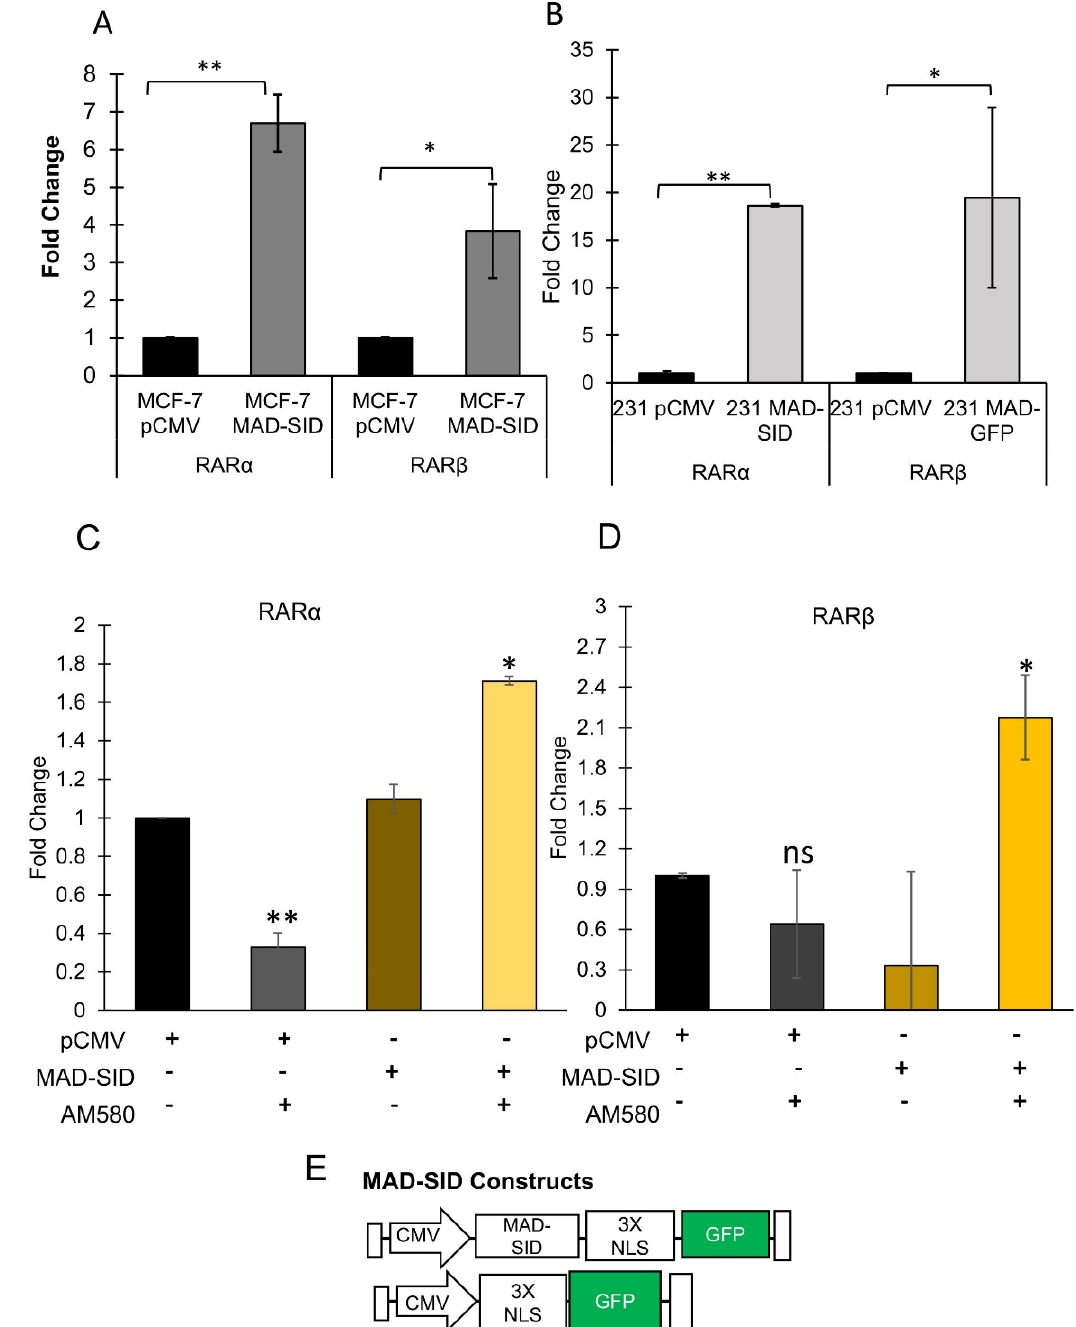
Figure 1. Expression of MAD-SID in MDA-MB 231 and MCF-7 cells increases RAR α and RAR β Expression: ( A , B ) MDA-MB 231 and MCF-7 cells were transfected with CMV-driven plasmids carrying a nuclear localization signal, GFP tag and MAD-SID sequence. The transfected cells were examined for the expression of RAR α and RAR β through RT-PCR. The expression of RAR α and RAR β increased in both the cell lines. The data presented are the mean fold change obtained from four independent experiments ( C , D ). The expression of RAR α and RAR β , respectively, was evaluated in the control (pCMV) and the MAD-SID-overexpressing MDA-MB-231 cells after treatment with AM580. The data presented are the average of the fold changes in expression obtained from two independent experiments. ( E ) Layout of the pCMV and MAD-SID constructs. The statistical analysis was conducted using an unpaired ‘ t ’ test; error bars represent mean ± SD. ** p < 0.01 and * p <